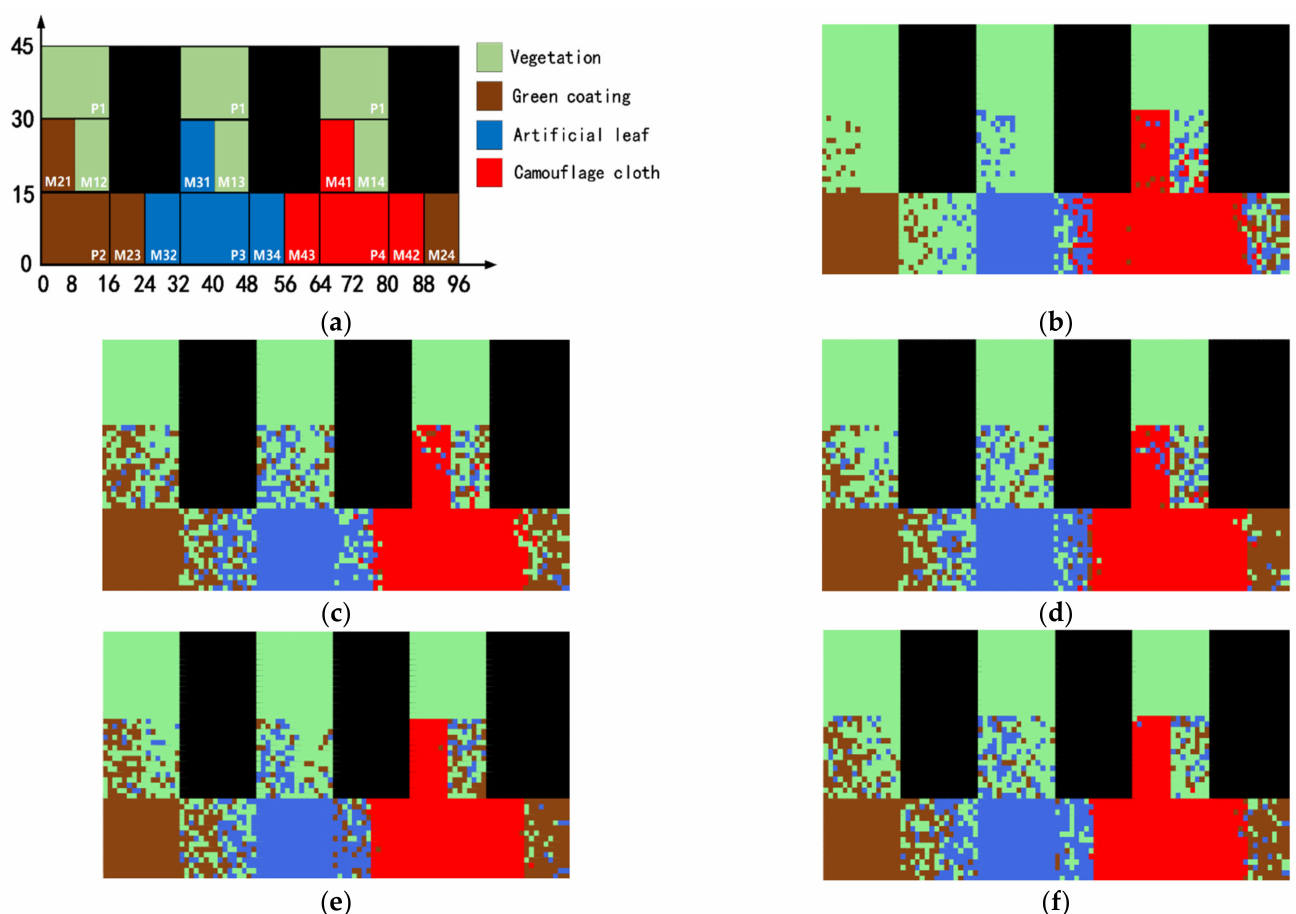
Figure 11. ( a ) Simulation data label diagram (Ground Truth); ( b ) original wavelength; ( c ) GA-BPSO; ( d ) IOIF; ( e ) Partitioned Relief-F ( f )